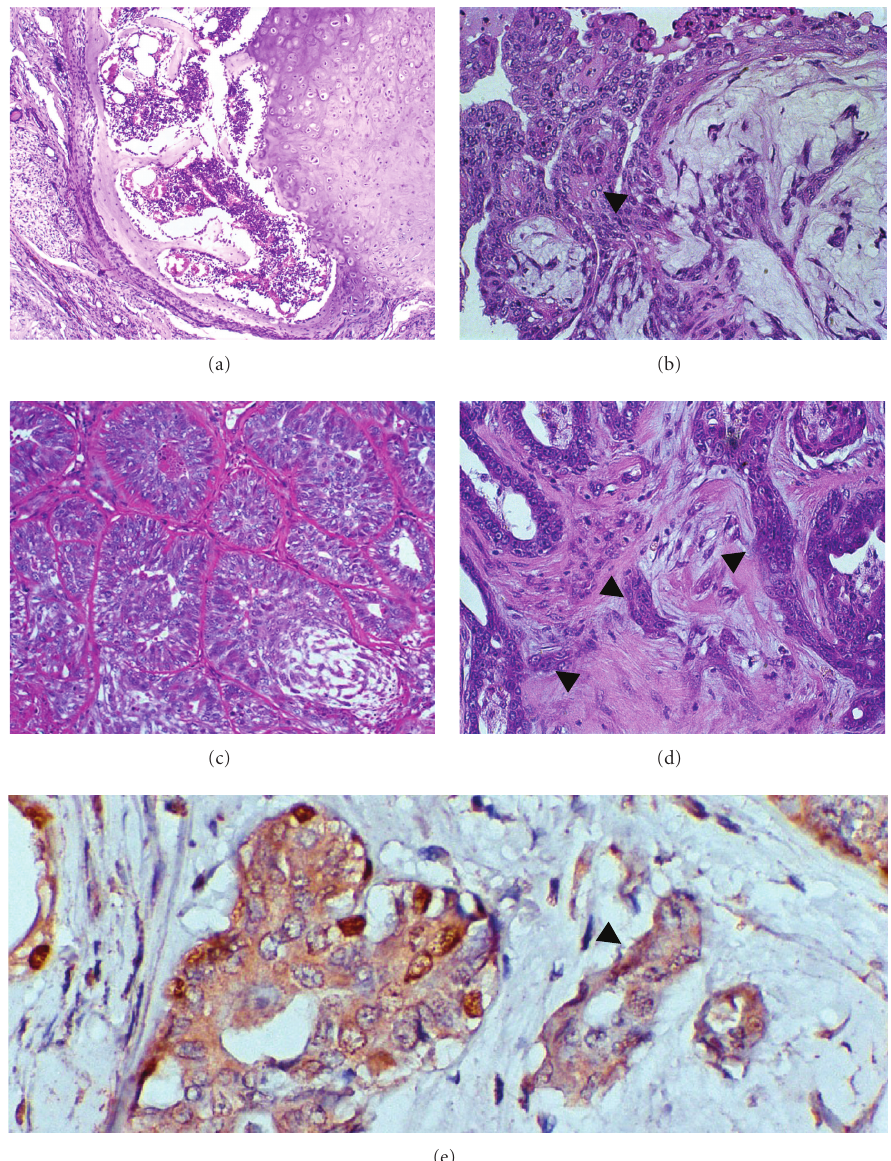
Figure 1: (a) Benign mixed tumor in canine mammary gland presenting chondroid and myeloid metaplasia. HE, 10x. (b) Ductal in situ carcinoma in benign mixed tumor in canine mammary gland presenting myoepithelial cells producing myxoid matrix. HE, 40x. (c) Carcinoma in benign mixed tumor in canine mammary gland presenting in situ carcinomatous areas and myoepithelial cell proliferation producing myxoid matrix. HE, 20x. (d) Carcinoma in benign mixed tumor in canine mammary gland presenting invasive areas in the adjacent stroma (arrow). HE, 40x. (e) Carcinoma in benign mixed tumor in canine mammary gland presenting absence of myoepithelial cells confirmed through negative p63 expression (arrow) in stromal invasive areas. Immunohistochemical stain with Mayer’s haematoxylin counterstain,